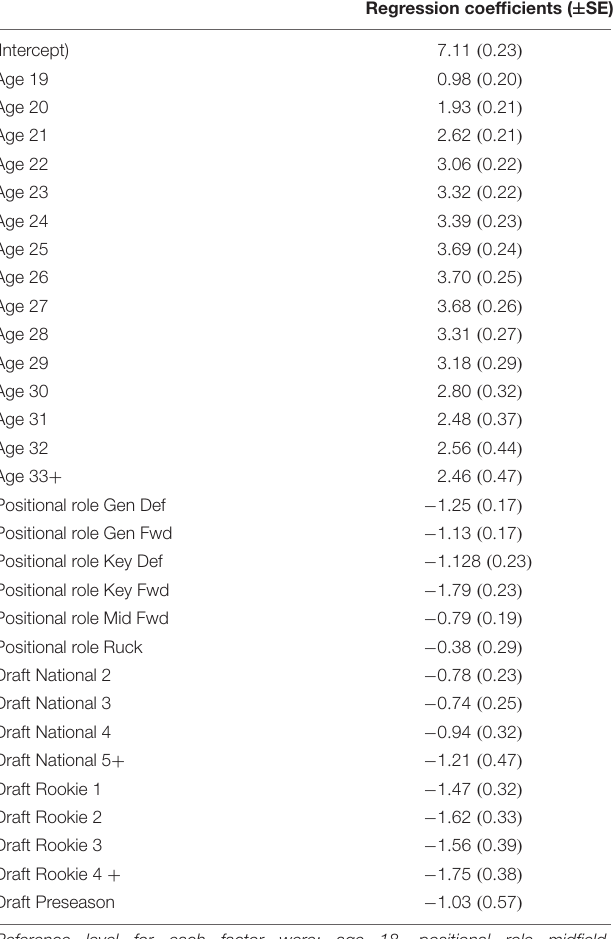
TABLE 1 | Model (1) fixed effect regression coefficients outlining the estimated difference in rating points from the reference level of each factor.